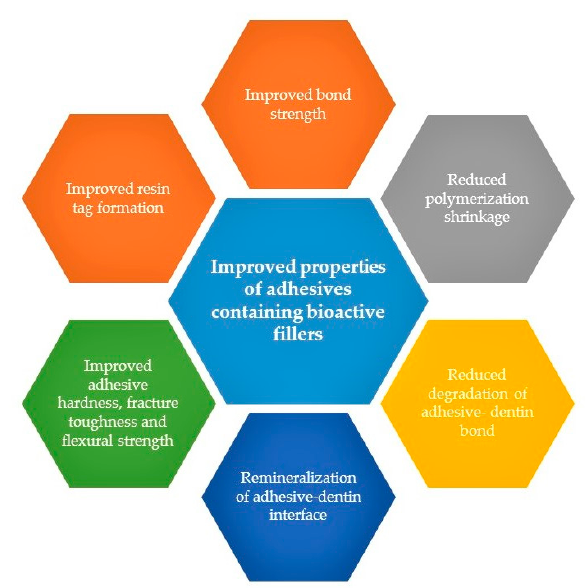
Figure 1. Improved properties shown by adhesives containing bioactive inoganic fillers [10,11].